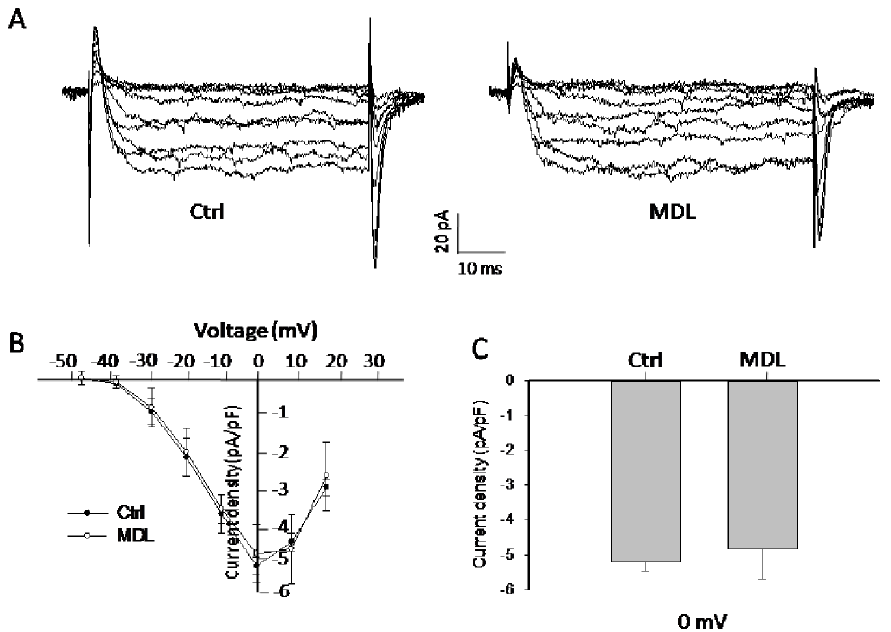
Figure 5. MDL-12,330A does not influence currents through voltage-dependent Ca 2 + channels. We employed extracellular Ba 2 + to replace Ca 2 + as the charge carrier to amplify current responses through Ca 2 + channels during the stimulus of depolarization. Ba 2 + currents were recorded in conventional whole-cell configuration from a holding potential of 2 70 mV to various depolarizing voltages ( 2 50 to 20 mV). A. representative current traces recorded under the treatments as indicated. B. current-voltage relationship curves of Ca 2 + channels from rat beta cell. C. summary of the mean current density of Ba 2 + currents recorded at 0 mV depolarization. Control (Ctrl, n=6); MDL-12,330A (MDL, 10 m M, n=6).